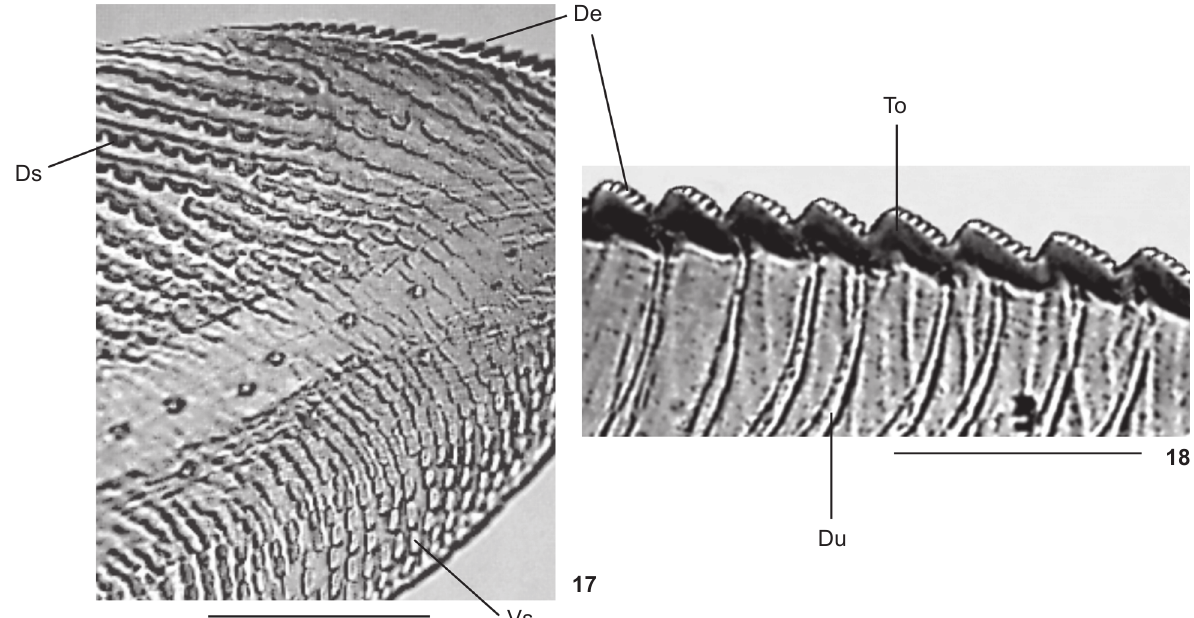
Figures 17-18. Diestostemma nasutum , female: (17) surface detail of the first ovipositor valvula near the apex, lateral view; (18) surface detail (superior portion) of the second ovipositor valvula at the apical third, lateral view. (De) Denticle, (Ds) dorsal sculptured area, (Du) duct, (To) tooth, (Vs) ventral sculptured area. Ds and Vs have scale-like processes. Scale bars: 0.1